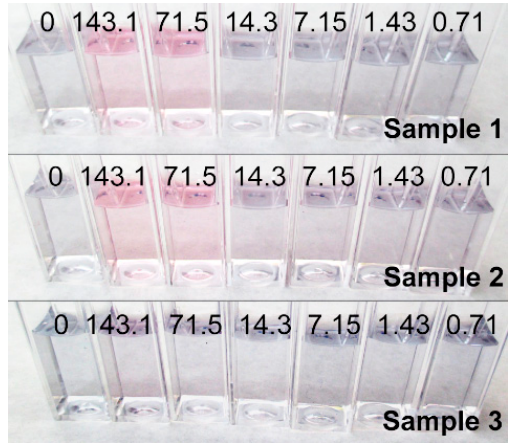
Figure 3. Preliminary naked-eye tests for lysozyme concentrations ranging from 143.1 to 0.71 µg/mL.